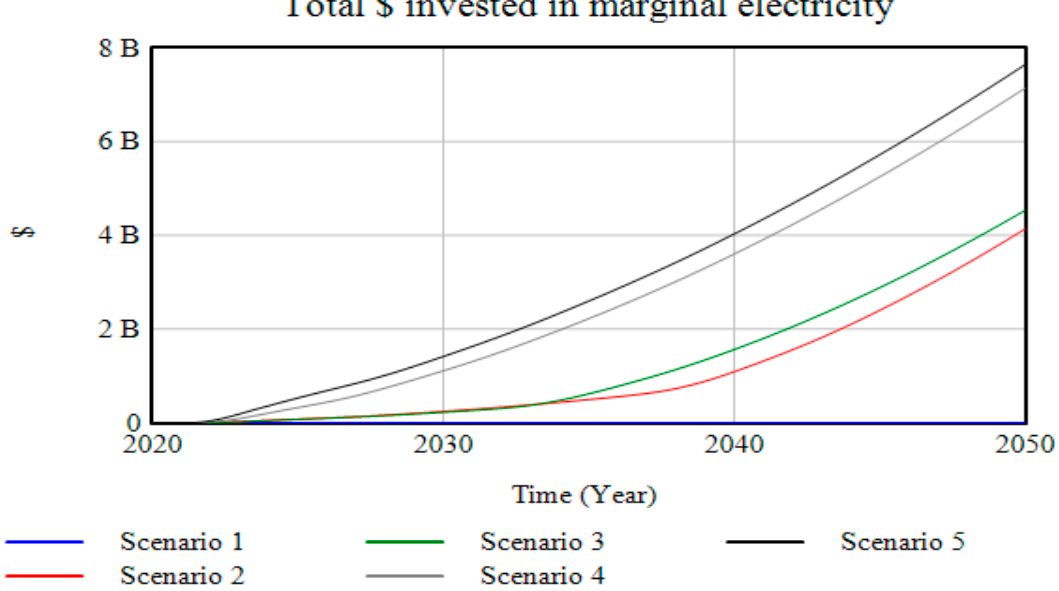
Figure 7. Marginal electricity investments.